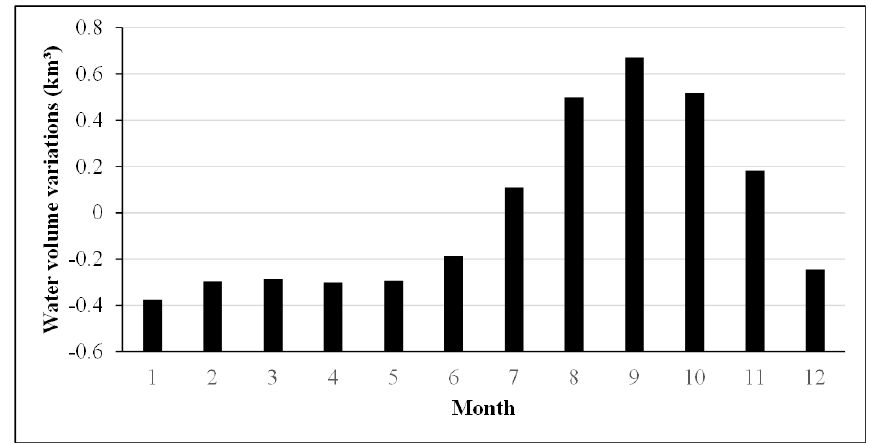
Figure 17. Monthly average water volume variation of the SPLC from 1992 to 2016.